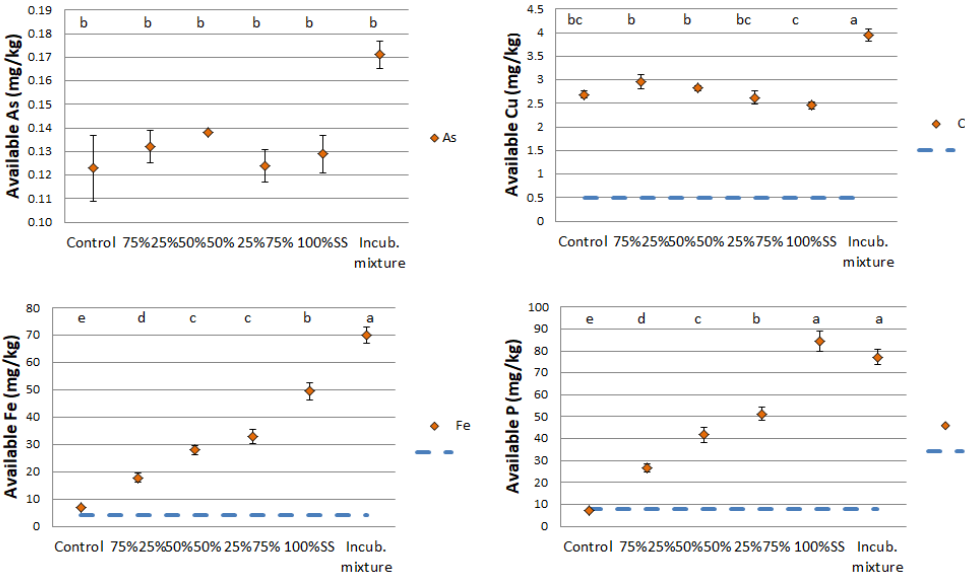
Figure 2. Concentrations (mg/kg) of metals (As, Cu, Fe) and P in soils treated with pyrolyzed materials (averaged value ± standard error; n = 3 or 4). Values for Cd are not shown because its concentration was always below the detection limit. The blue line represents a reference level for the different elements at the following values: Cu (0.5 mg/kg), Fe (4 mg/kg) and P (8 mg/kg) according to Benton Jones (1999). Letters are comparing the treatments.